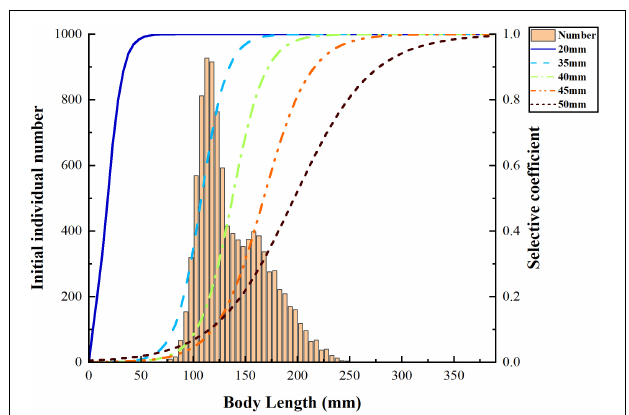
FIGURE 1 | Initial body length distribution of small yellow croaker and different selective curves of stow net.